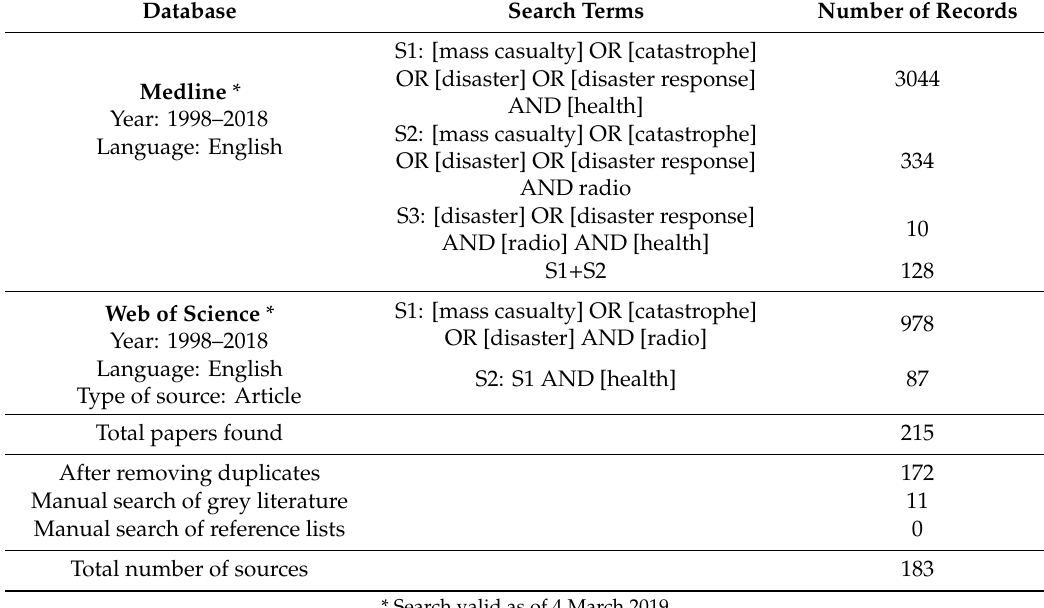
Table 1. Overview of the database search.